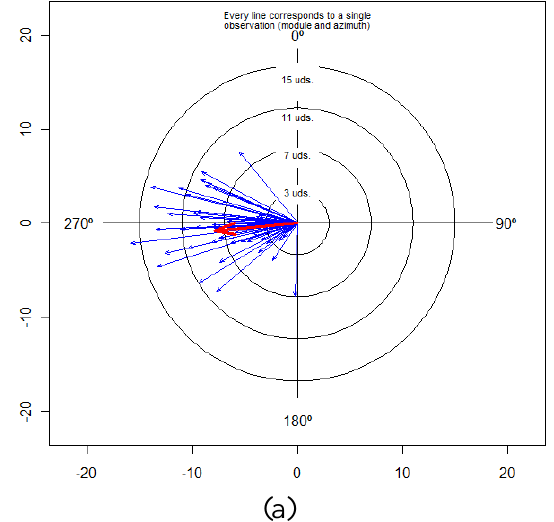
Figure 5. Data in circular diagram (2D). (a) XZ wall-plane; (b) XY ground-plane; (c) plane perpendicular to these